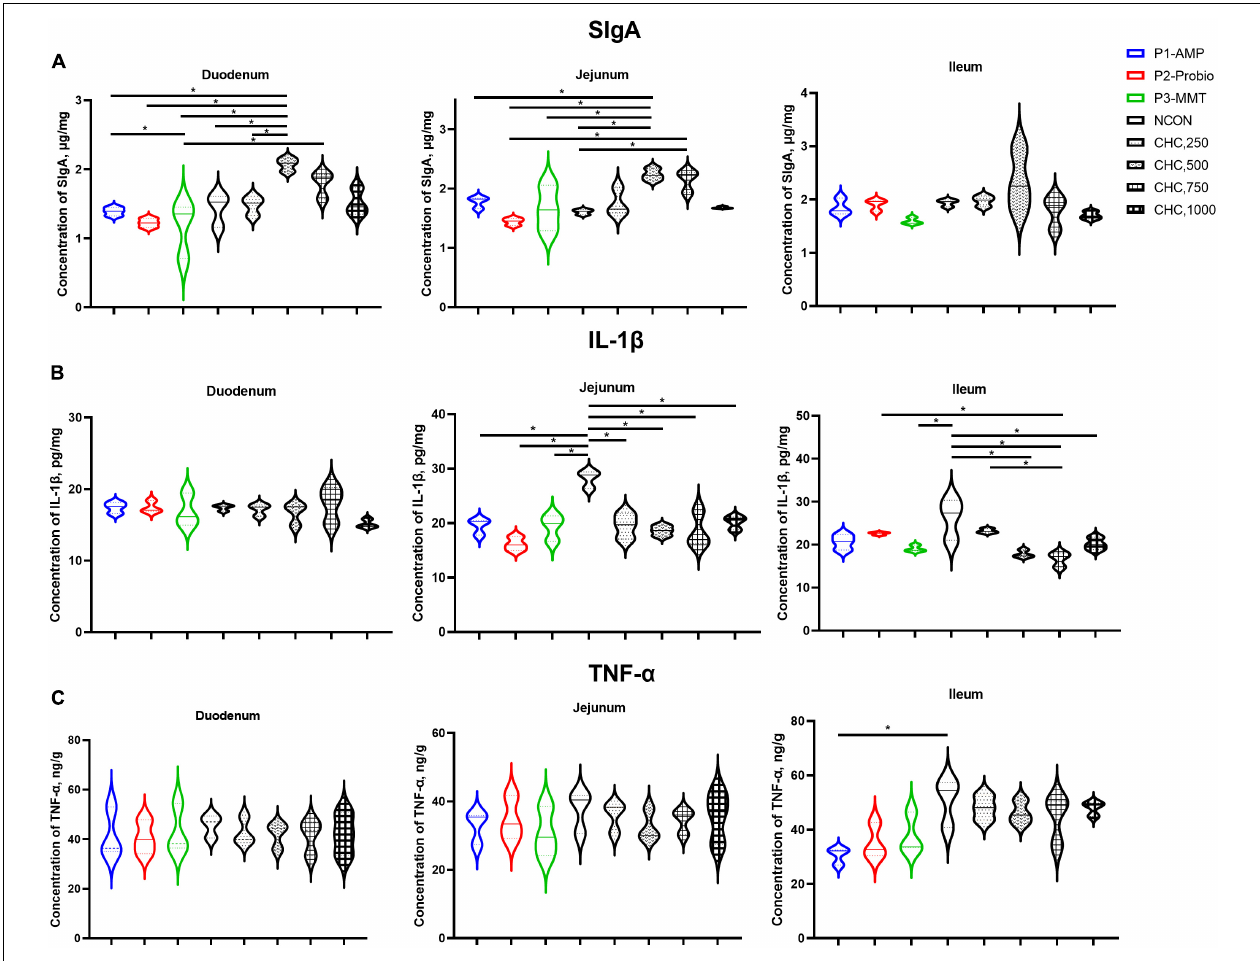
FIGURE 1 | Effects of CHC on intestinal mucosa secretory immunoglobulin A (SIgA), interleukin-1 β (IL-1 β ), and tumor necrosis factor- α (TNF- α ) levels in broilers ( n = 6). (A) The concentration of secretory immunoglobulin A (SIgA) in the mucosa of duodenum, jejunum, and ileum. (B) The concentration of interleukin-1 β (IL-1 β ) in the mucosa of duodenum, jejunum, and ileum. (C) The concentration of tumor necrosis factor- α (TNF- α ) in the mucosa of duodenum, jejunum, and ileum. The “*” indicates a significant difference between the two treatments ( p < 0.05). Values are expressed as means (the solid line between two dashed lines) ± SEM. Experimental diets were corn-soybean meal basal diets (NCON) and basal diets supplemented with 250, 500, 750, or 1,000 mg/kg CHC. Three additional diets containing 200 mg/kg antibacterial peptide (AMP), 200 mg/kg calsporin (Probio), or basal diets with 500 mg/kg montmorillonite (MMT) were set as the positive